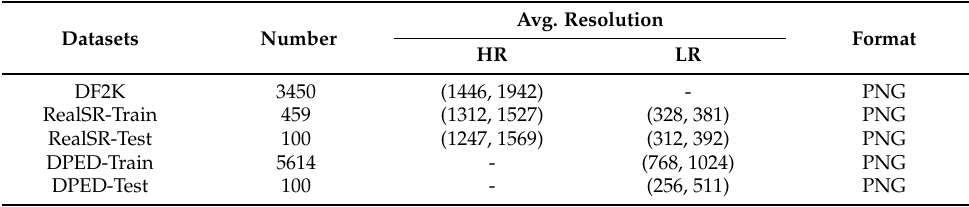
Table 1. Summarized information about image